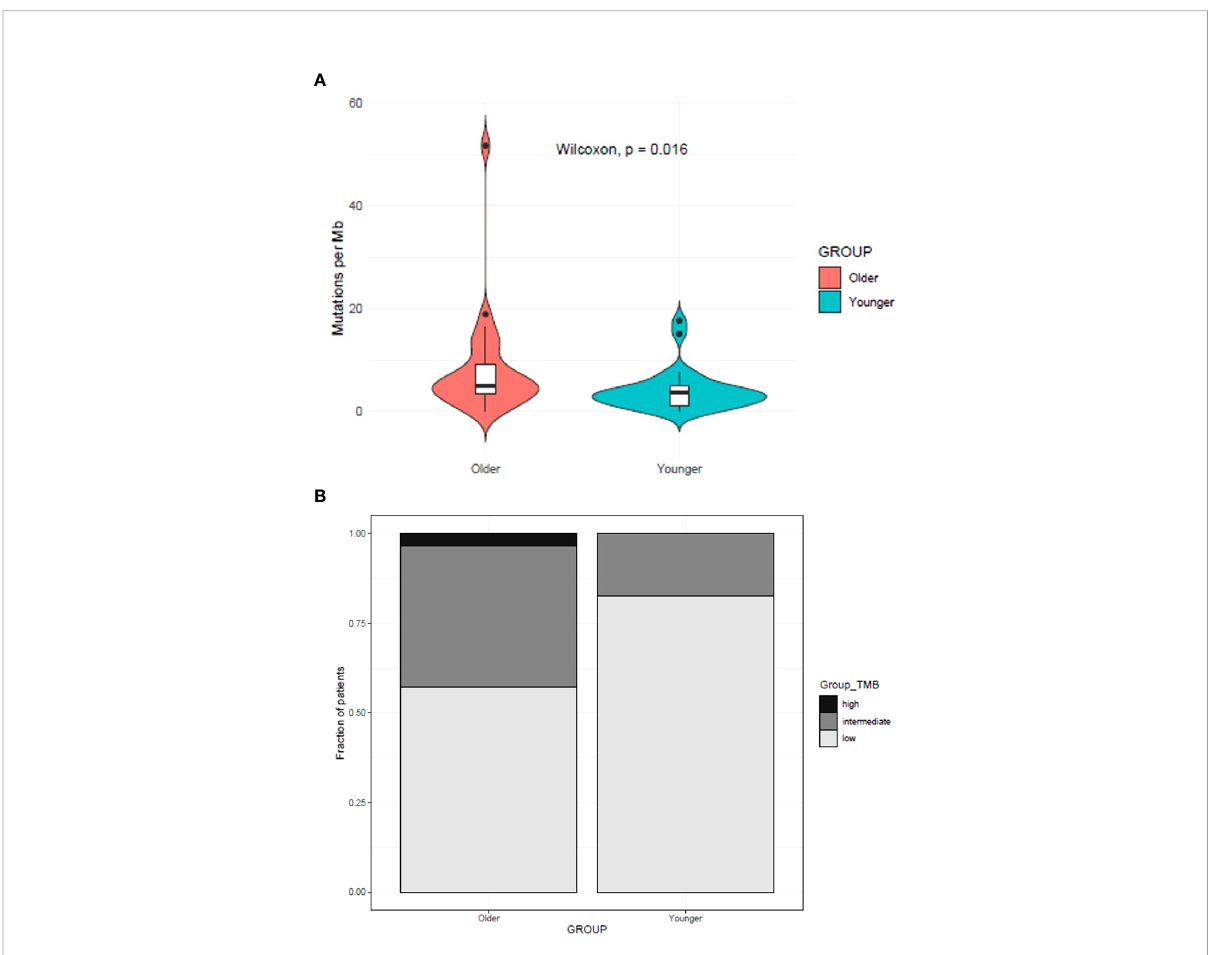
TABLE 2 Comparison of rearrangements detected in younger vs older patients with NSCLC. GROUP GENE 1 GENE 2 n DESCRIPTION YOUNGER PATIENTS ROS1 EZR